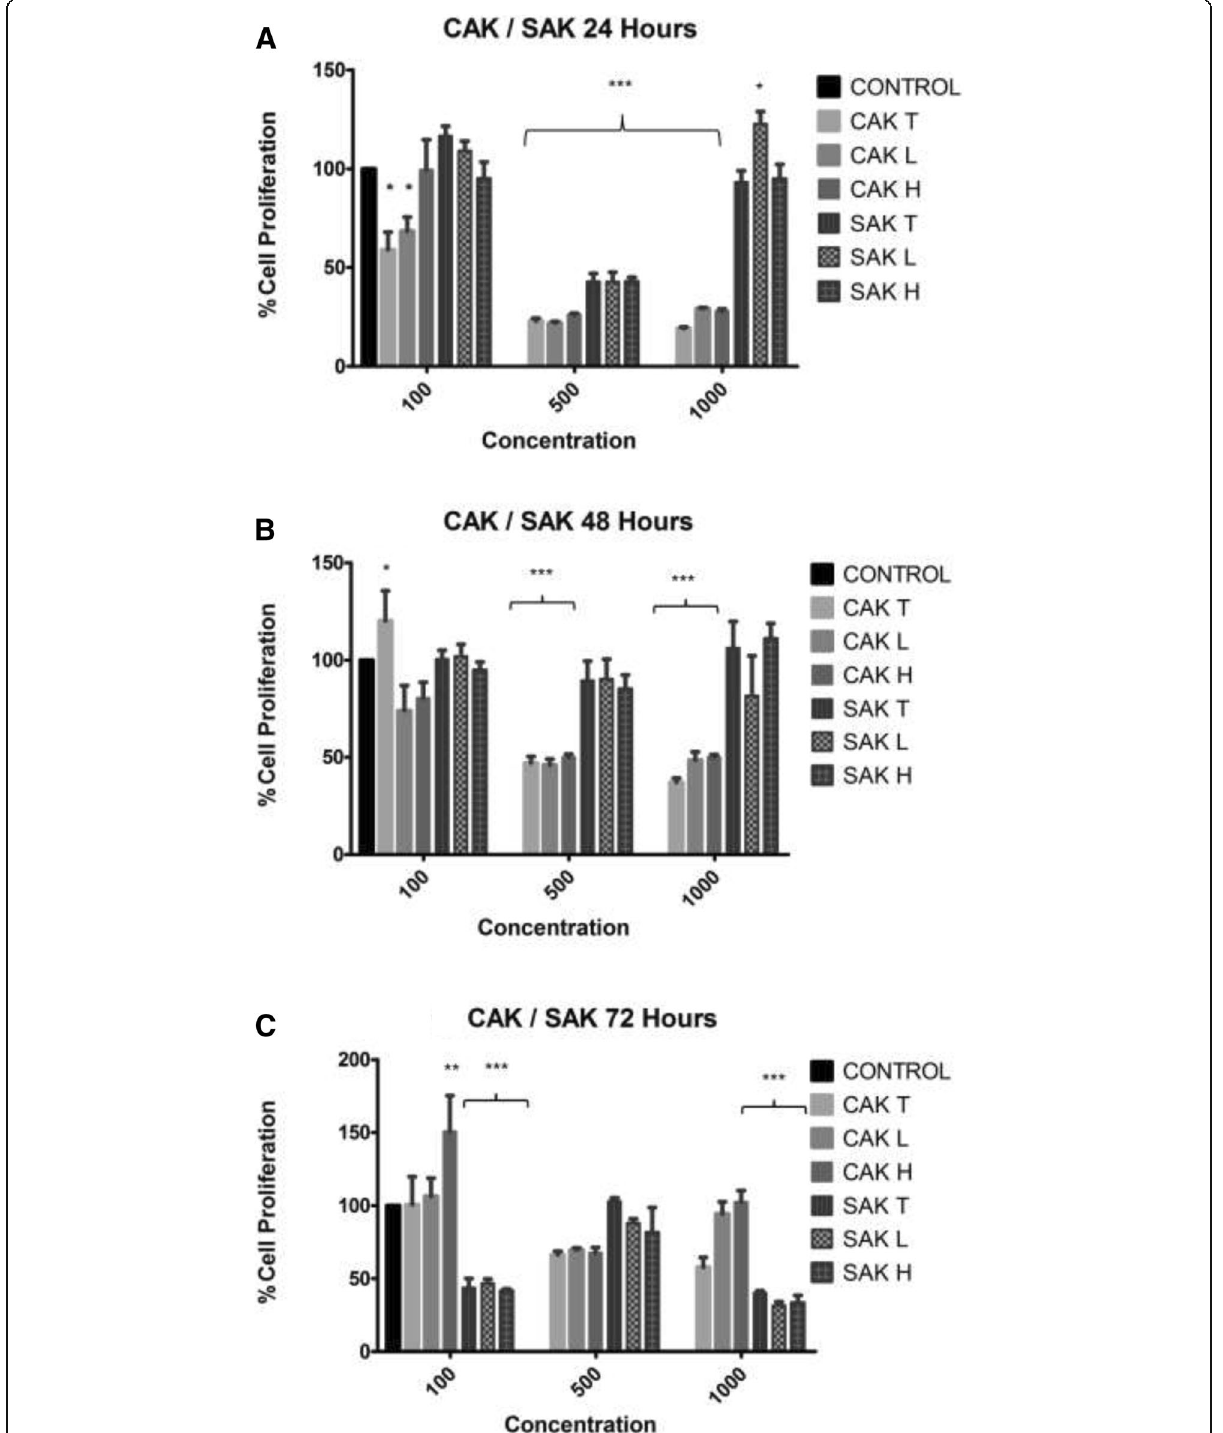
Fig. 1 Percentage of HT-29 cells as determined by crystal violet assay in 96-well plates following 24 ( a ), 48 ( b ), and 72-h ( c ) exposure to CAK and SAK extracts. Data is shown as mean±SEM of three separate experiments. Significant differences between treated and control samples are indicated by * P ≤ 0.05, ** P ≤ 0.01, *** P ≤ 0.001 compared to respective controls (Two-way ANOVA followed by Tukey ’ s multiple comparisons